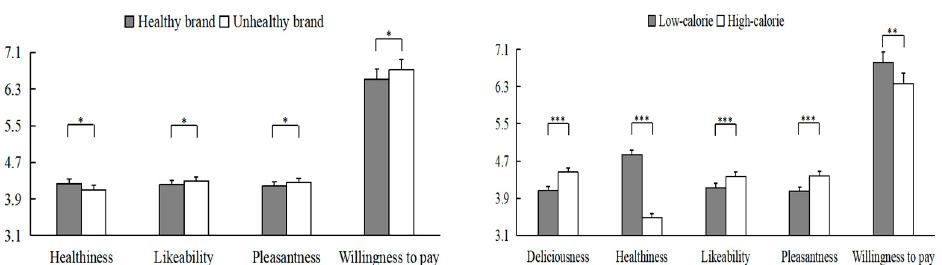
Figure 4. The main effects of brand type and food calories on product evaluation in Study 2. Error bars show the standard errors of the means. * denotes p < 0.05, ** denotes p < 0.01, and *** denotes p < 0.001.